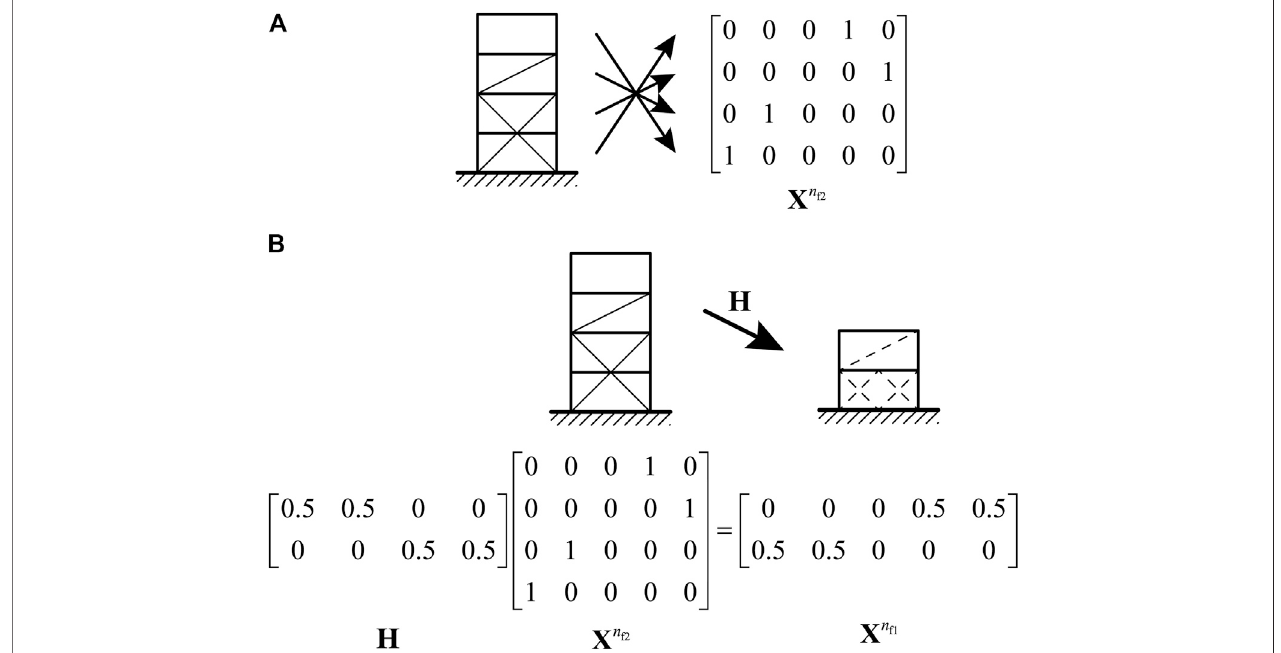
FIGURE 3 | Illustration of the condensation process; (A) example of X n f 2 for a 4-story 1-span frame, (B) condensation from 4-story frame to 2-story frame.